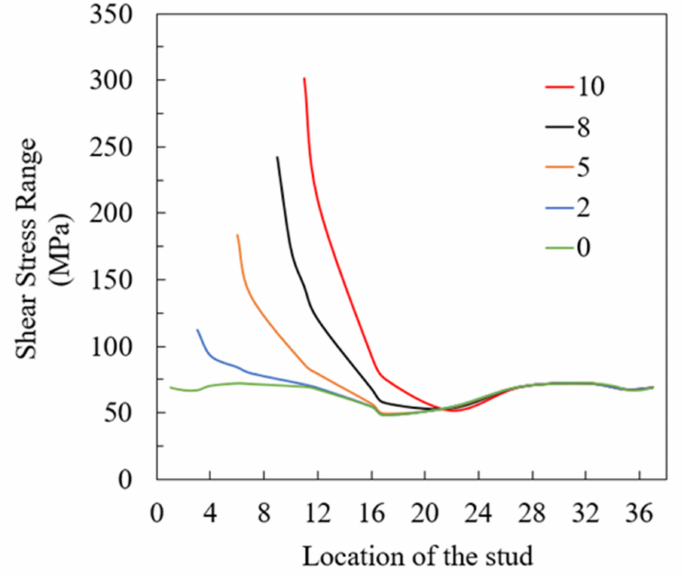
Figure 11. Shear stress range across the composite beam after removal of